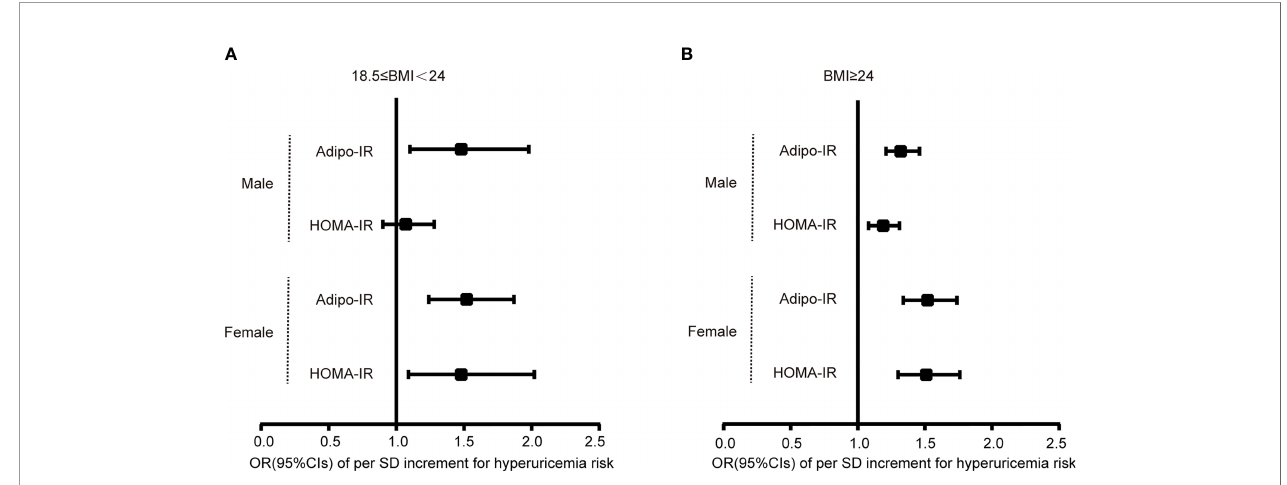
FIGURE 3 | Logistic regression analysis for the OR of per SD increment of Adipo-IR or HOMA-IR for hyperuricemia risk in normal BMI (A) and elevated BMI (B) subgroups. Models were adjusted for age, HbA1c, eGFR, hypertension, and dyslipidemia.